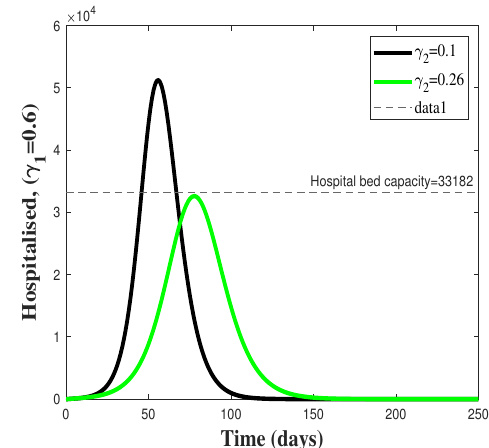
Fig. 8: Population level plots for hospitalized in- dividuals for varying values of γ 2